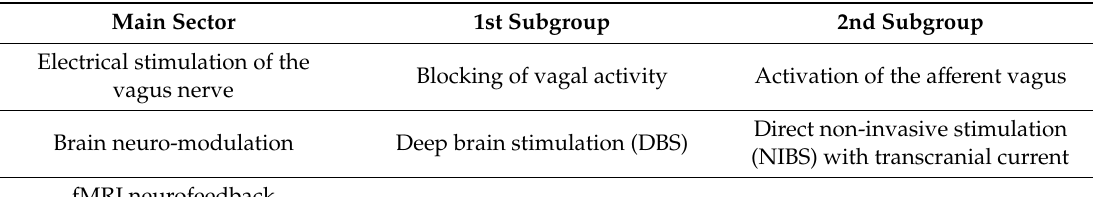
Table 2. Physical methodologies in the therapy of obesity (for details and references please see